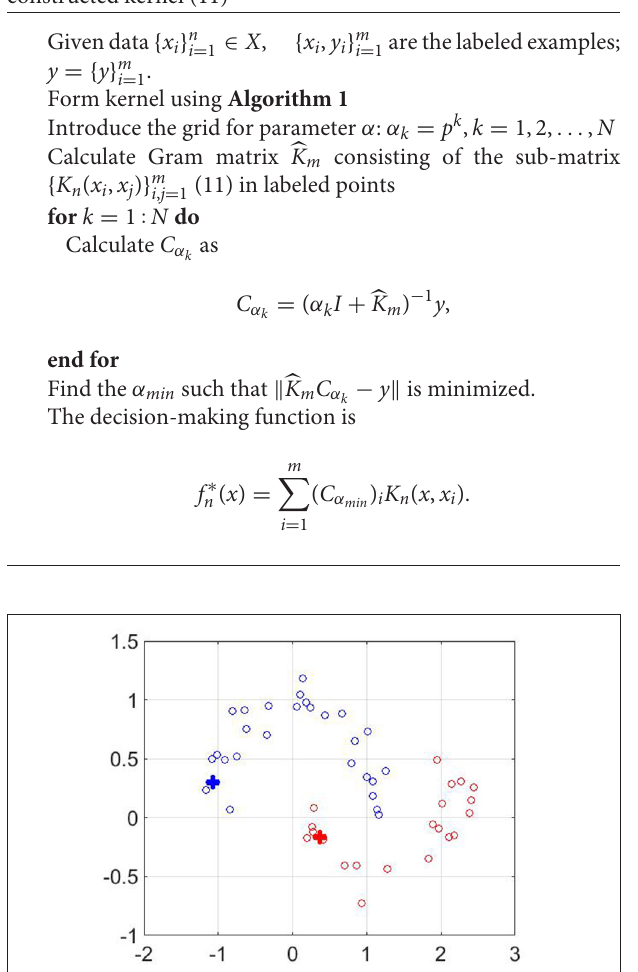
unlabeled points. In particular, for n = 50, to label all points without error, it is enough to take only one labeled point for each of two classes ( m = 2). At the same time, if the set of unlabeled